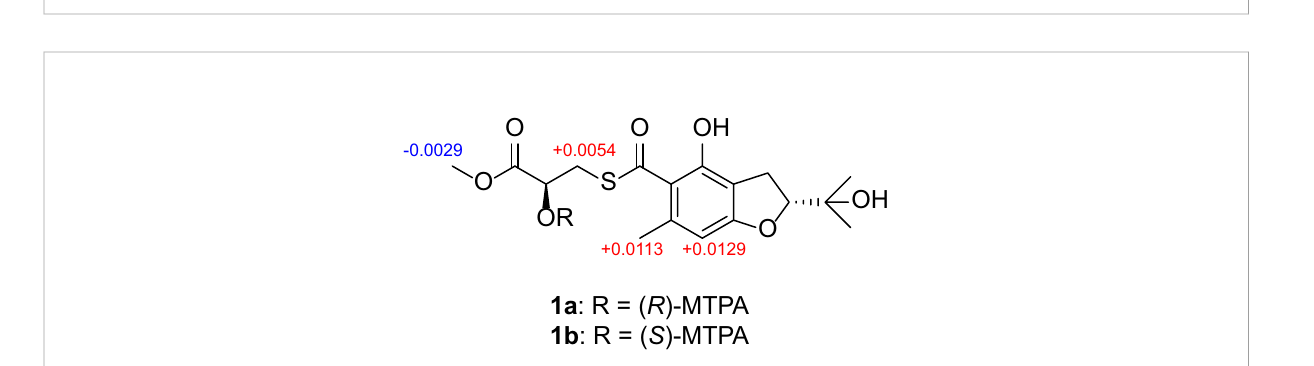
FIGURE 2 Key correlations of compounds 1 − 3 and 5 − 6.